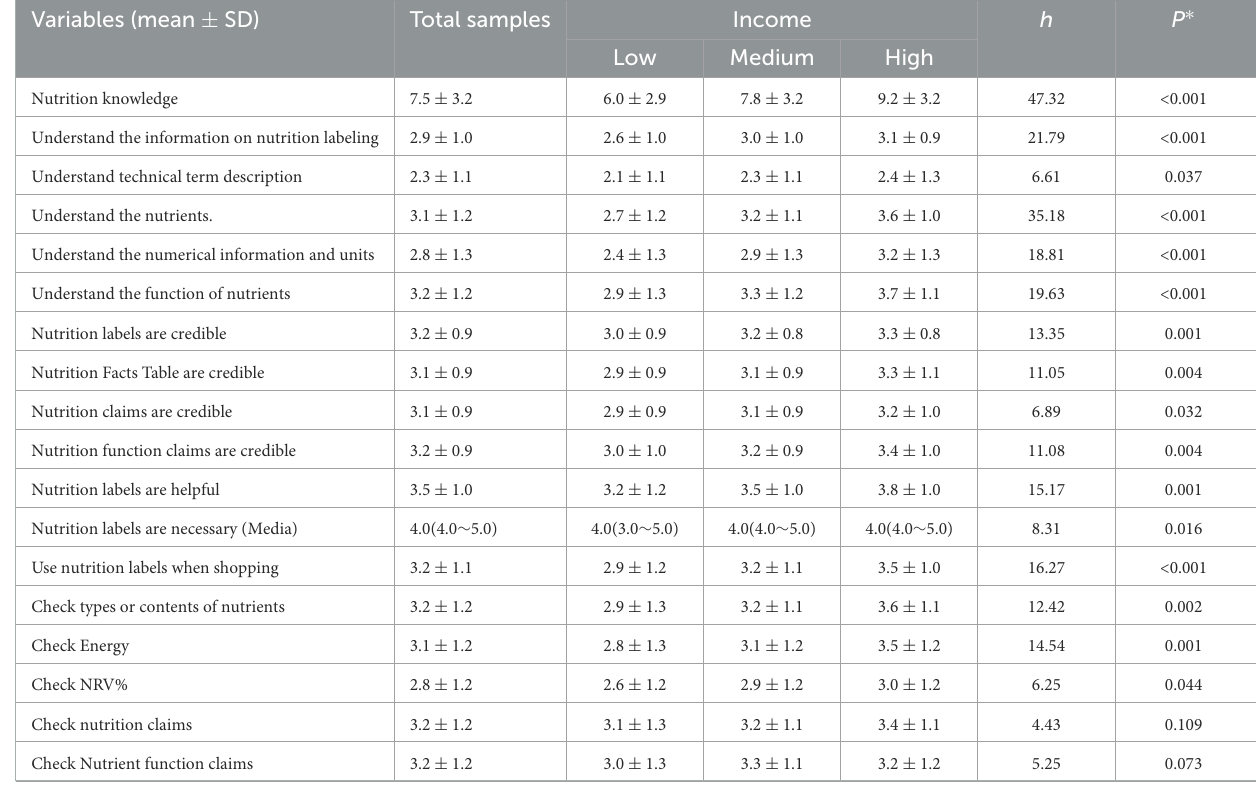
TABLE 3 Mean scores on knowledge, attitude, and practice scales completed by 636 residents, by income. Variables (mean ± SD) Total samples